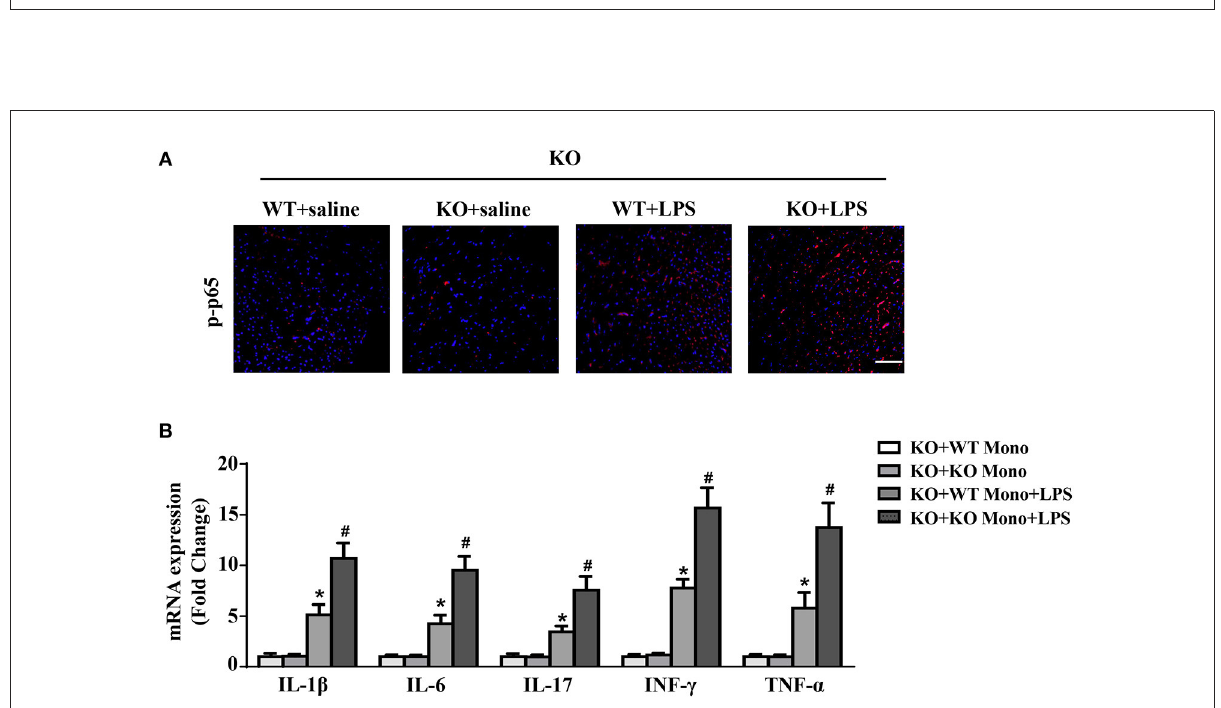
FIGURE8 WT monocyte adoptive transfer reduces cardiac inflammation in LPS-treated IL-12p40 − / − mice. (A) The immunofluorescence analysis of p-p65 in heart sections of each group ( n = 6; scale bar, 50 µ m). (B) qRT-PCR analysis of IL-1 β , IL-6, IL-17, TNF- α , and INF- γ mRNA expression levels in the hearts of mice in each group ( n = 6). * P < 0.05 compared with the KO + WT Mono group. # P < 0.05 compared with the KO + WT Mono + LPS